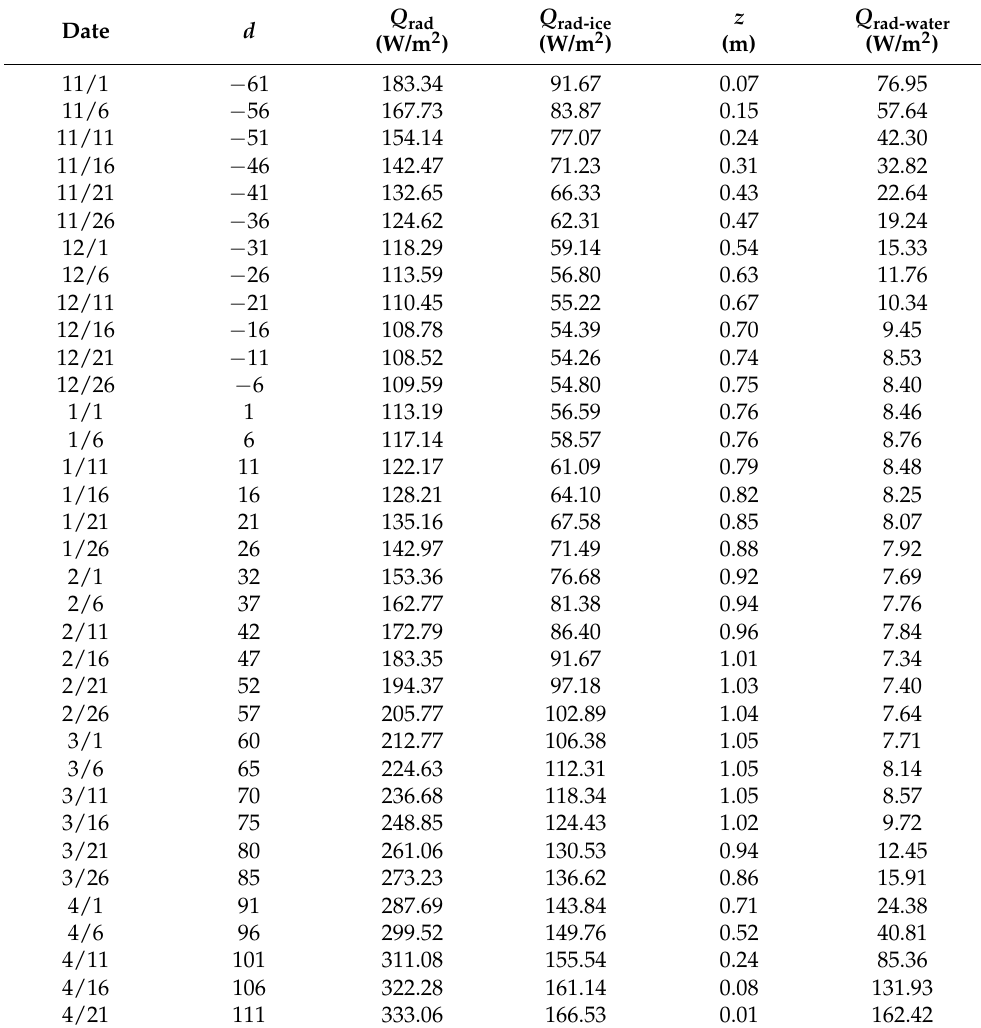
Table 1. Seasonal variations of solar radiation flux penetrating into